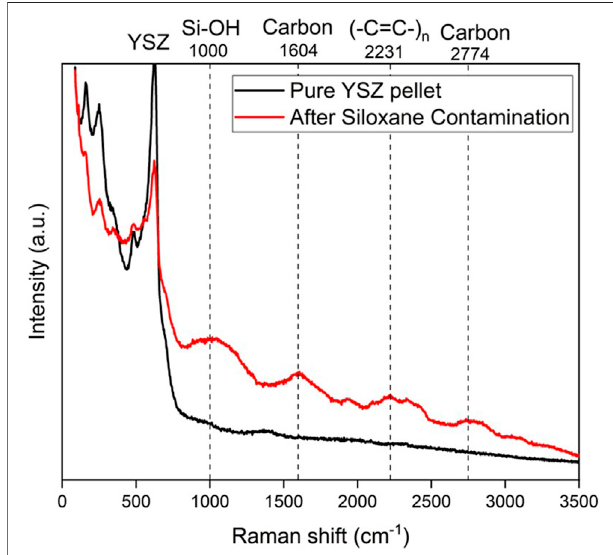
FIGURE 11 | EIS and equivalent circuit fi tting results of YSZ pellets with porous Ag electrodes under L4 contamination with H 2 +H 2 O+N 2 +L4 as the fuel at 750 ° C.